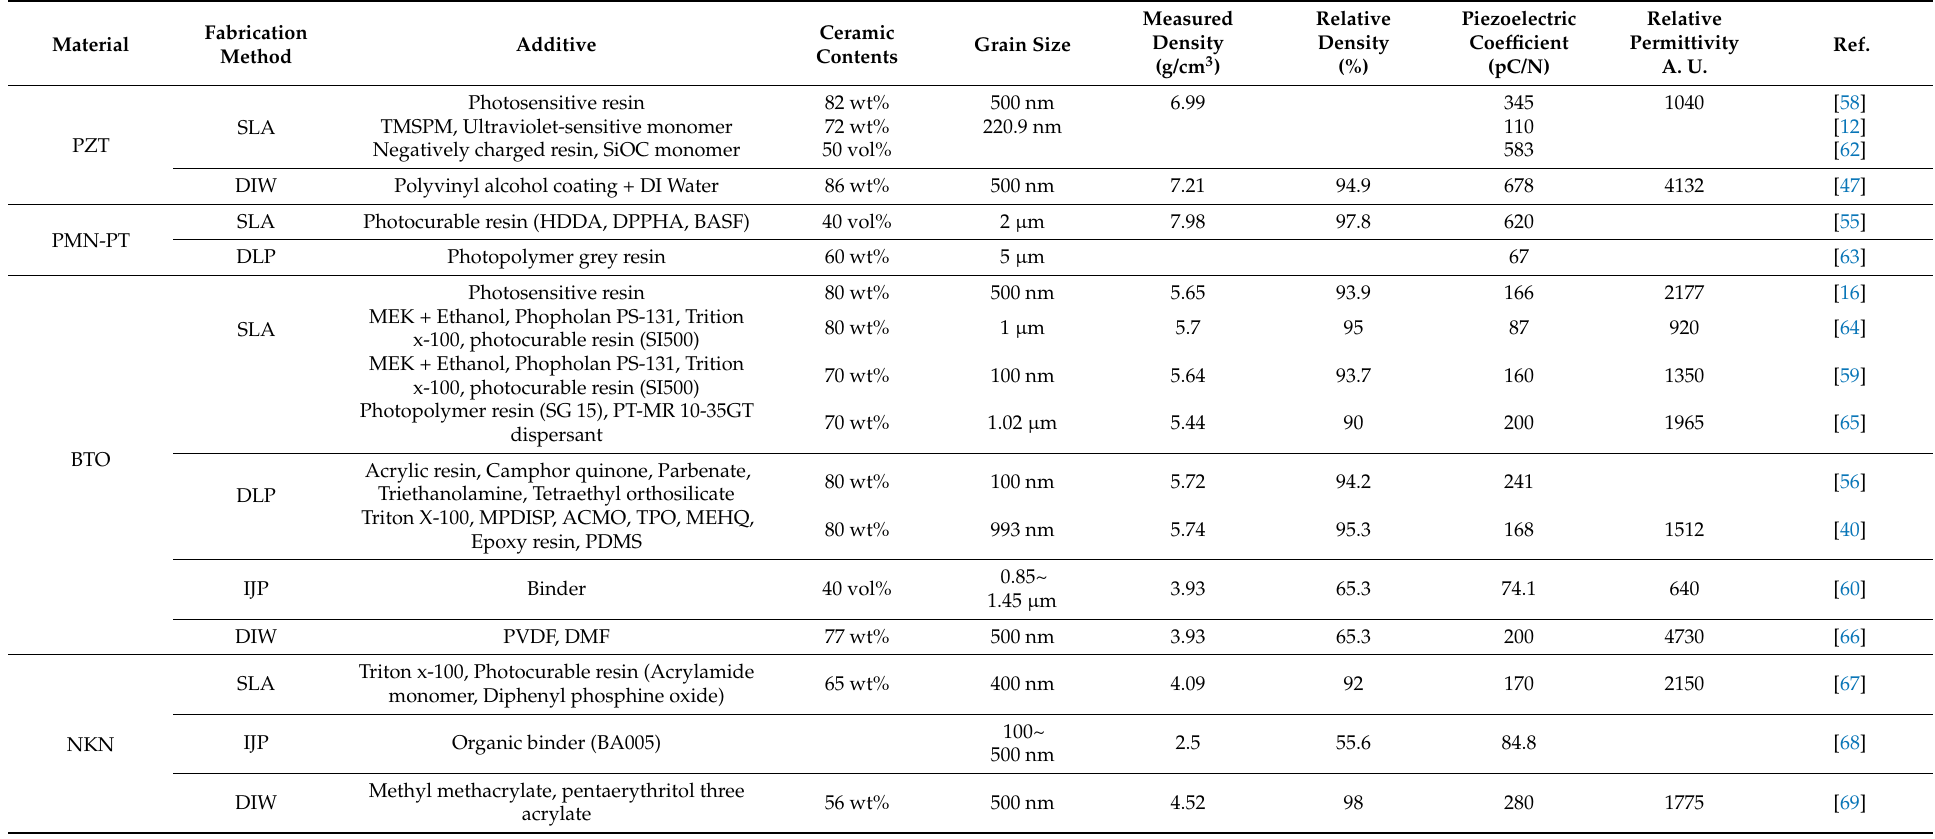
Table 3. Comparison of piezoelectric ceramics 3D